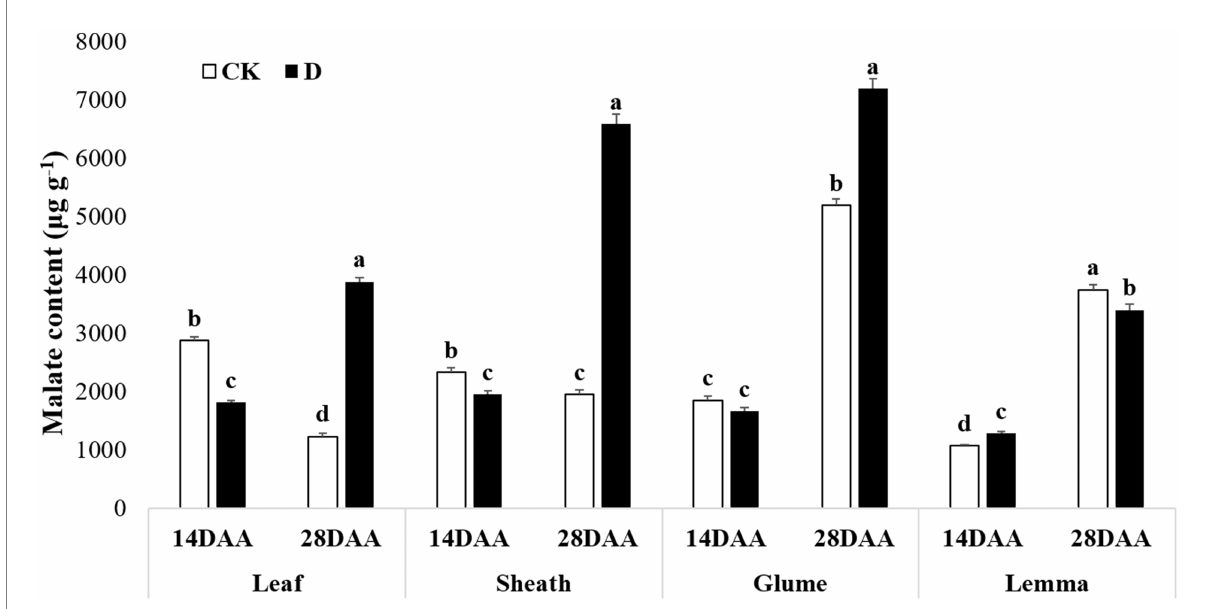
FIGURE 6 Malate content in the flag leaf, the sheath, the glume and the lemma under drought stress. Different small letters within the same organ meant a significant difference at the 0.05 probability